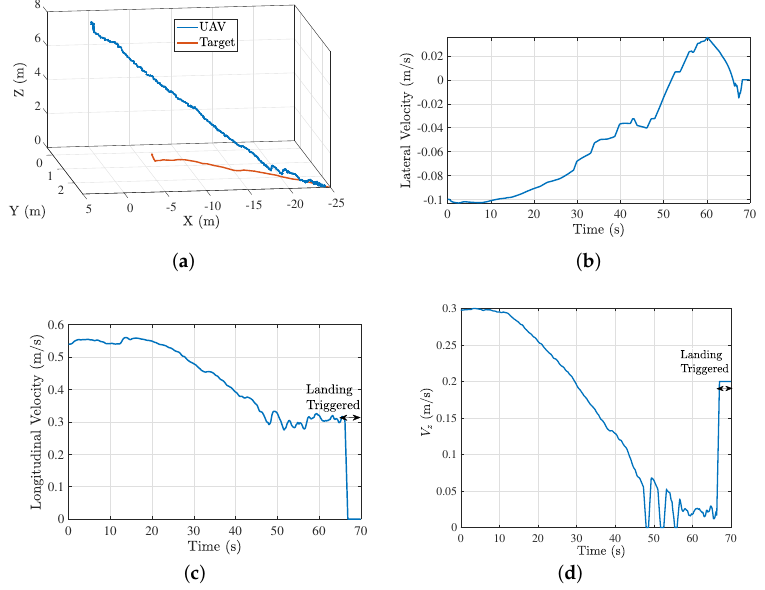
Figure 12. Trial 1: trajectory and velocity profile characteristics for moving target landing. ( a ) Tra- jectory followed by the quadcopter to land on a moving target; ( b ) lateral velocity profile ( a , b , c ) = ( 10,130, − 131 ) ; ( c ) longitudinal velocity profile ( a , b , c ) = ( 40,130, − 161 ) ( d ) V z profile ( a , b ) = ( 6,3 )